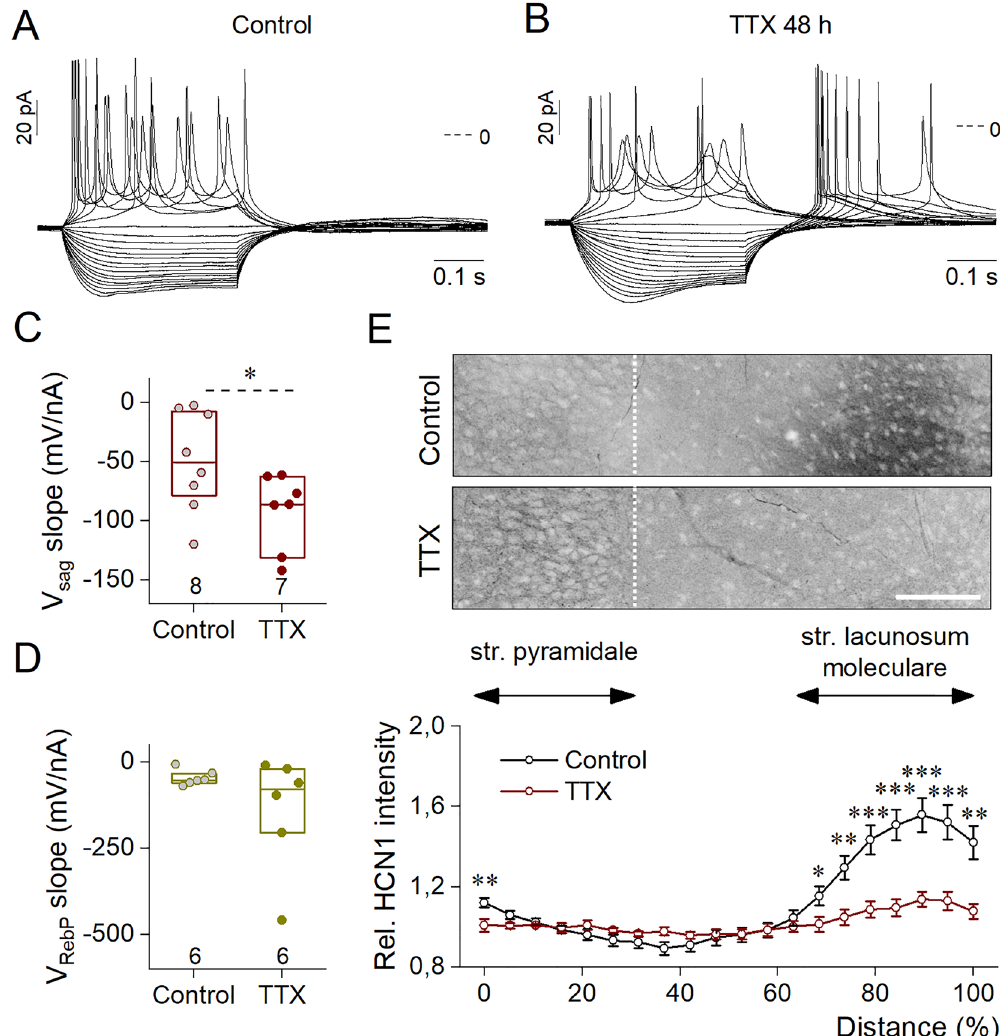
Figure 6. Representative voltage traces obtained from organotypic slice cultures under current step stimulation from a control ( A ) and an activity-deprived ( B ), CA1 pyramidal neuron at DIV17 and DIV14, respectively. The voltage sag slope parameter ( C ) became significantly more negative, while the slope of RebP ( D ) changed to a less degree following TTX treatment. Number of recorded cells is indicated on the graphs, where box plots indicate medians and 25–75% range of data. ( E ) Activity deprivation induced a more proximal redistribution of HCN1 from the str. lacunosum moleculare (str. l.m.). Representative images were processed identically and display inverted a-HCN1 immunofluorescence from control and TTX-treated slices. Dashed lines indicate the edge of str. pyramidale (str. pyr.). Scale bar represents 100 μm. At the bottom, graph indicates relative HCN1 signal intensity values along 100 μm wide lines oriented perpendicular between str. pyr. and str. l.m., normalized to the average HCN1 intensity within the str. pyr. of the same slice. Data were calculated form 16 (control) or 11 (TTX-treated) intensity profiles and are expressed as mean ± SEM. Altogether, 6 ( C , D ) or 4 ( E ) independent organotypic hippocampal slice cultures were used for the measurements. Statistical analysis was performed with Mann–Whitney U test ( C , D ) or independent samples t-test (( E ); *p < 0.05; **p < 0.01; ***p <